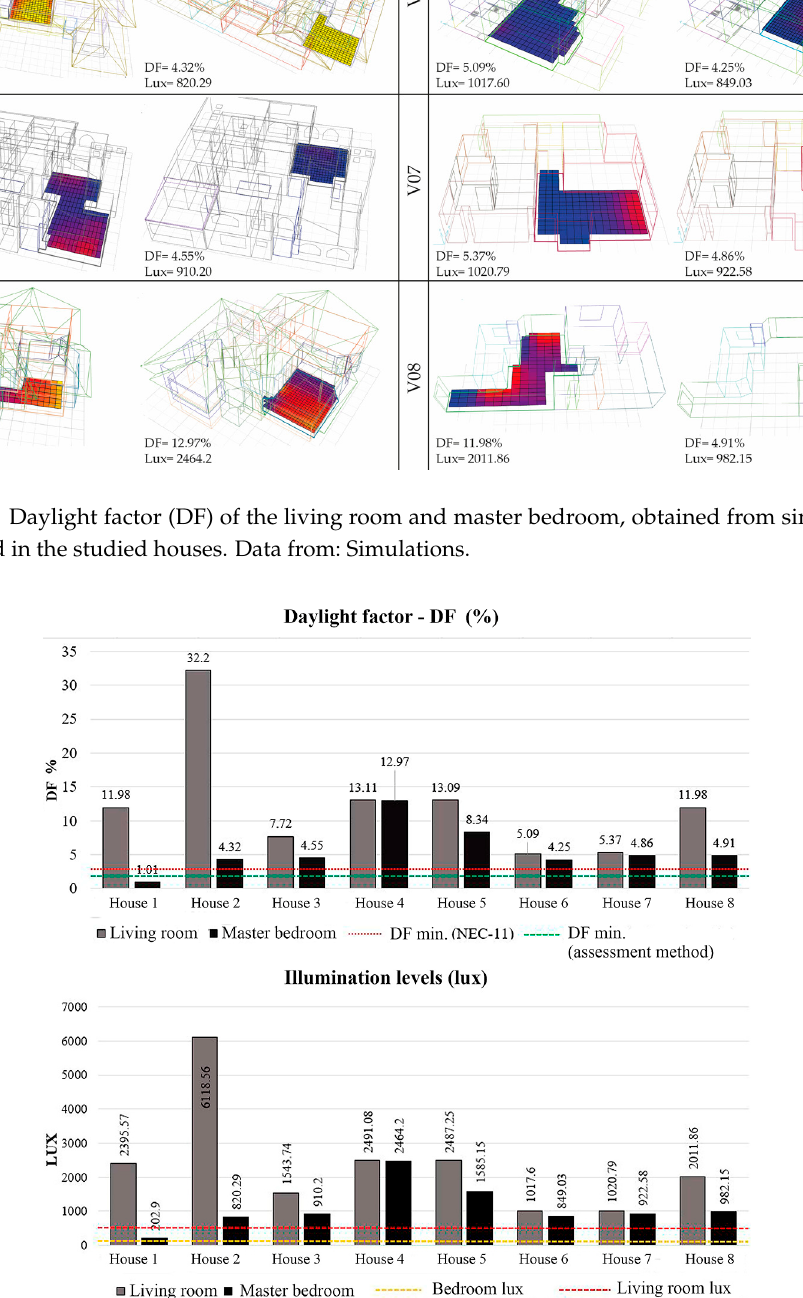
Figure 11. Daylight factor and illumination levels (lux) of the studied houses compared with minimum requirements according to regulations. Data from: Simulations.